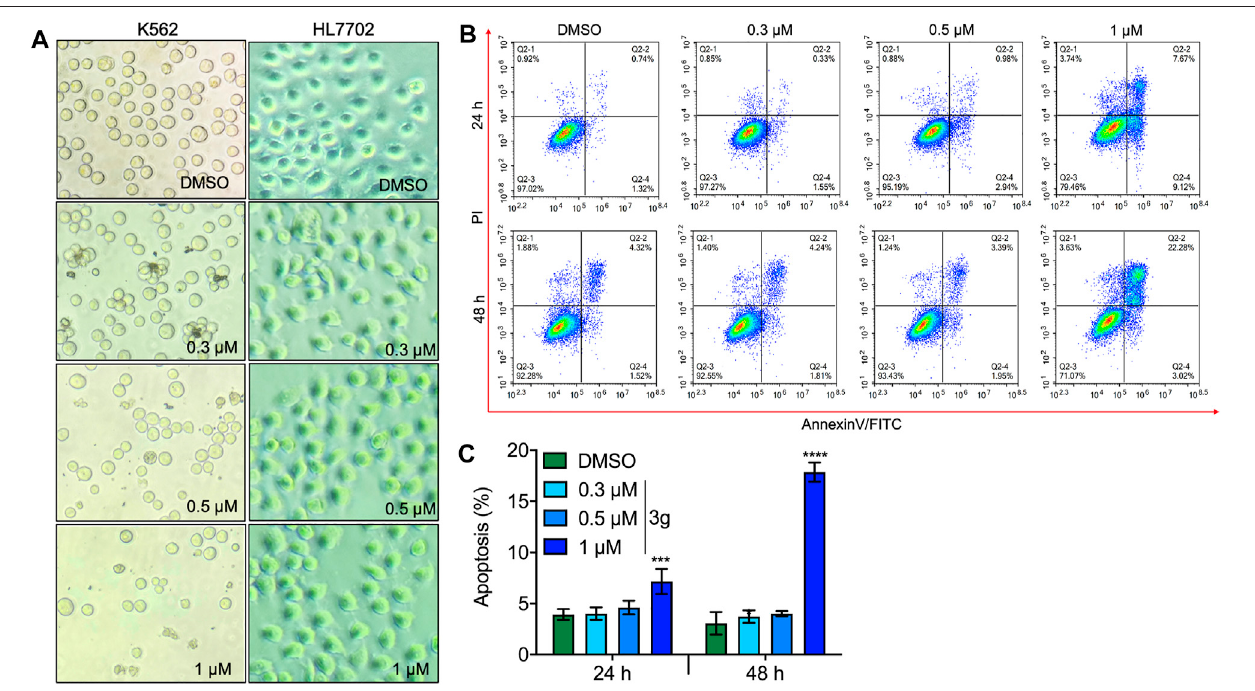
FIGURE 2 | 3g induces apoptosis in both dose- and time-dependent manners. (A) Dose-dependent cell morphology variations in K562 and normal hepatocyte cellsattheindicated3gconcentrations(40X),for72 h. (B) Flowcytometricanalysisofapoptosiscausedbyindicateddosesof3gtreatmentat24and48 hinK562cells. (C) Densitometry of the apoptotic cells percentage at an indicated time interval of 3g incubation. Data are represented as mean ± SD ( n = 3; *** p < 0.001 and **** p < 0.0001 vs.